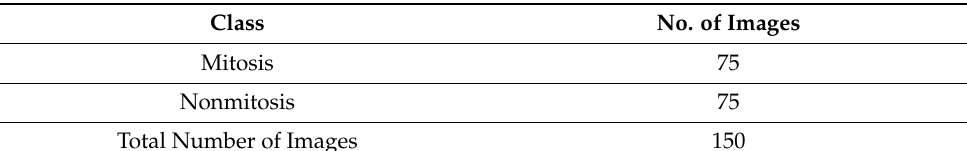
Table 1. Dataset details.